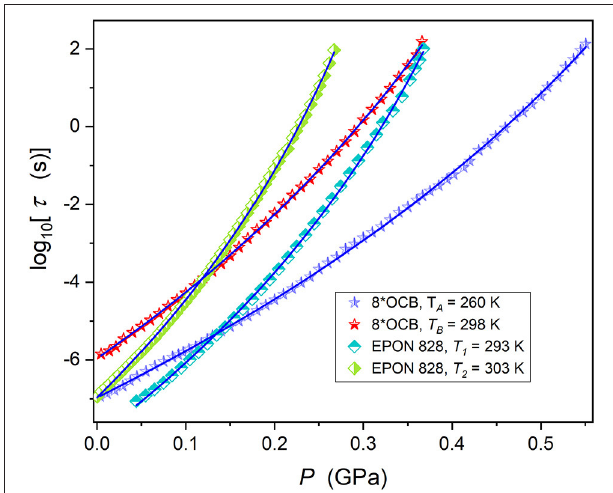
FIGURE 2 | Pressure dependences of the primary relaxation time in 8 * OCB and EPON 828, for two isotherms. Experimental data are portrayed by Equation (15), with parameters given in Table 2 . Temperatures related to tested isotherms are given.